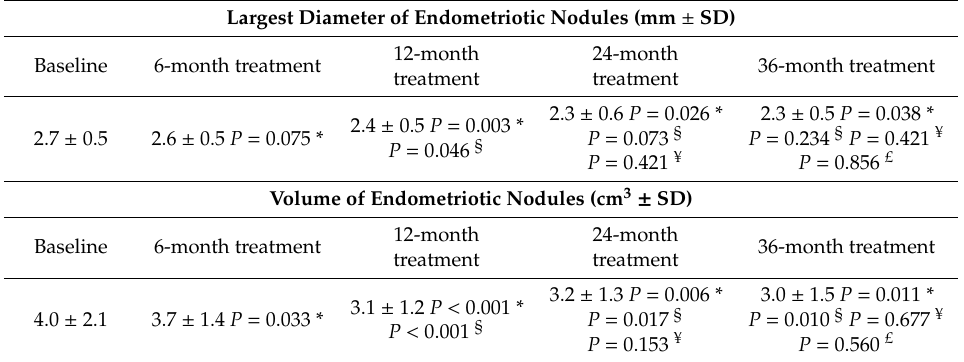
Table 3. Changes in main largest diameter and volume of rectosigmoid nodules during the treatment.